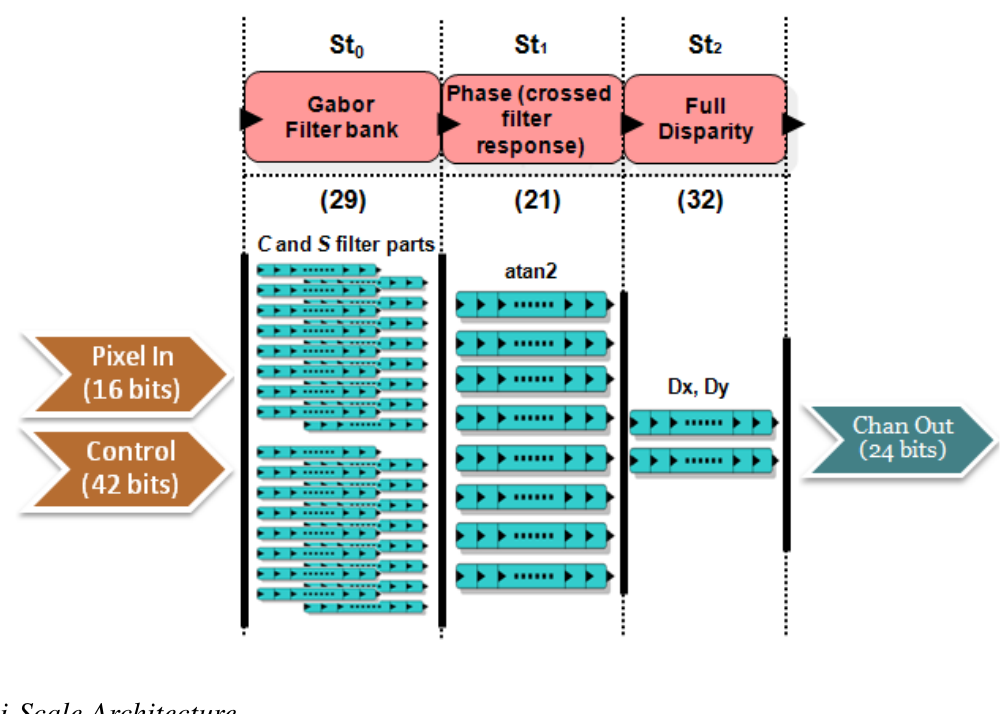
Figure 5. Scheme of the pipelined stages for the phase-based vector disparity core. It describes the computation stages (from St brackets) and the number of parallel datapaths for each one of